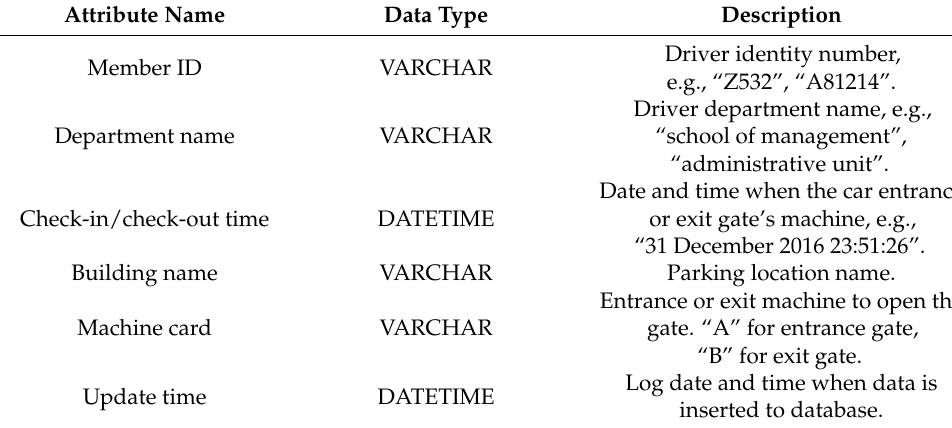
Table 1. The attribute of data collected.